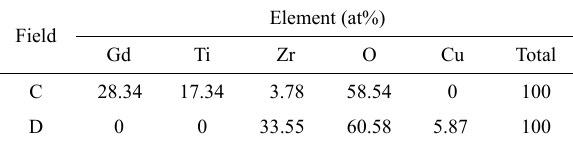
Fig. 4 EDX mapping images of consolidated Zr-45 specimen with pressure time 25 s: (a) representative BSE image of the matrix, (b) mixed elemental mapping image of three elements (Zr: green; Gd: blue; Ti: red), and respective elemental mapping images of (c) Gd, (d) Ti, (e) O, and (f) Zr. able 2 T elemental spotting analysis of “C” and “D”